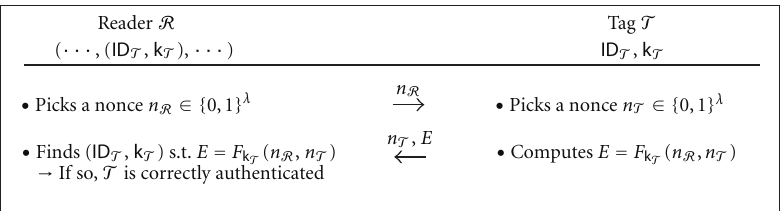
F 1: SK-based authentication protocol.